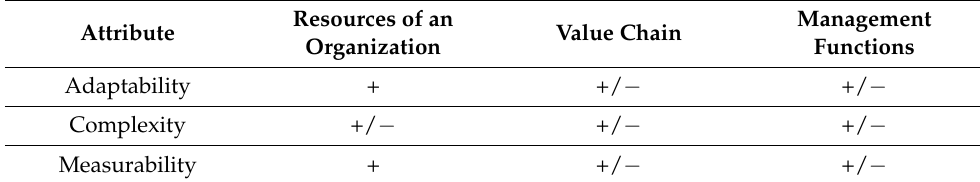
Table 10. Comparison of the analyzed approaches in terms of their suitability for the development of a green organization